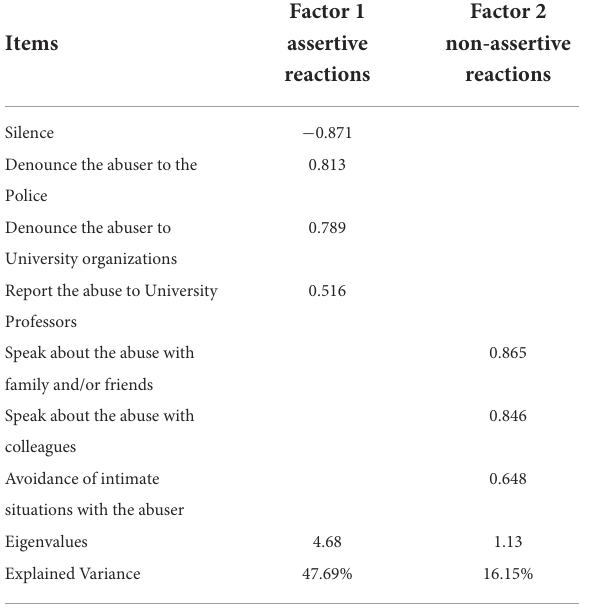
TABLE 3 Cell sizes of gender roles by sex.